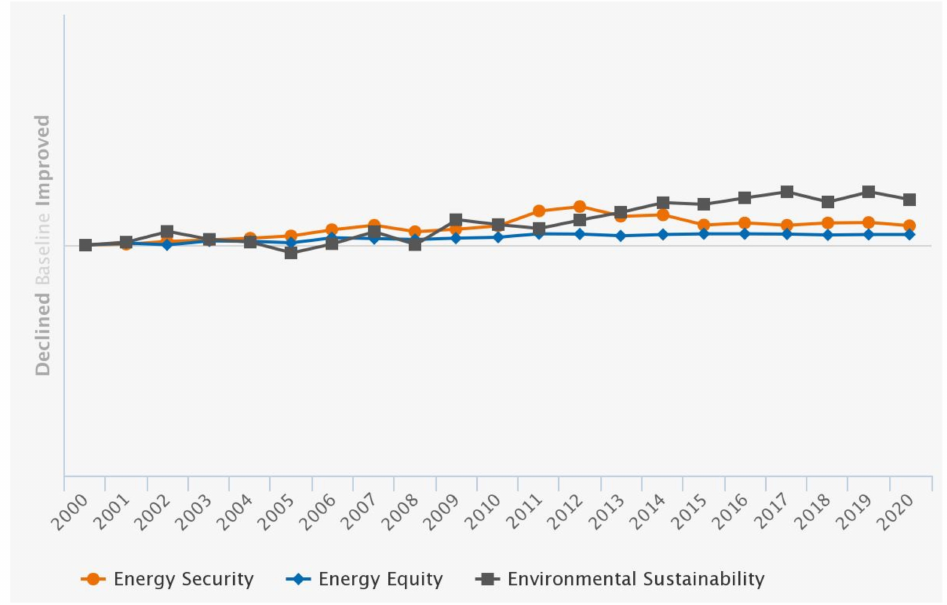
Figure 17. Trends of the components of the Energy Trilemma Index for Denmark, 2000–2020 (based on